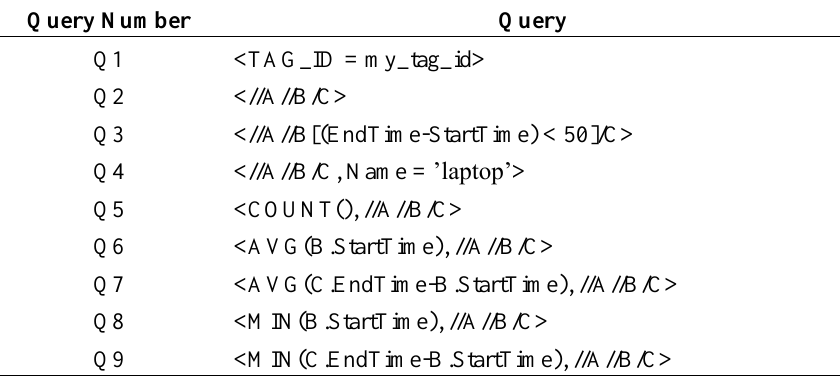
Table 5. Representative query set.